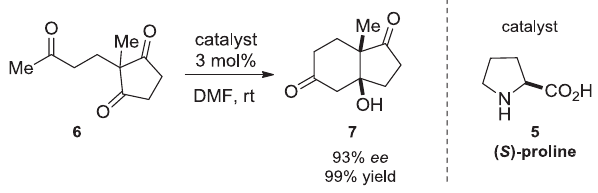
Figure 3. Asymmetric aldol reaction catalyzed by ( S )-proline, see Ref. [27,